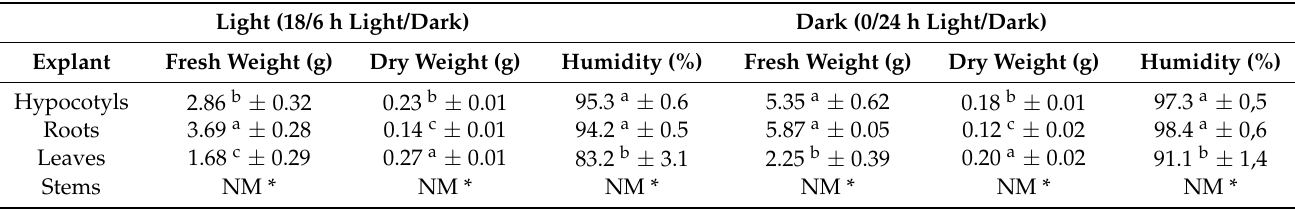
Table 2. Fresh weight, dry weight, and humidity content of T. officinale callus two weeks after induction for different explant types and light (medium MS supplemented with sucrose 2.3%, 0.1 mg/L of NAA, and 2.0 mg/L of BAP). Light (18/6 h Light/Dark)